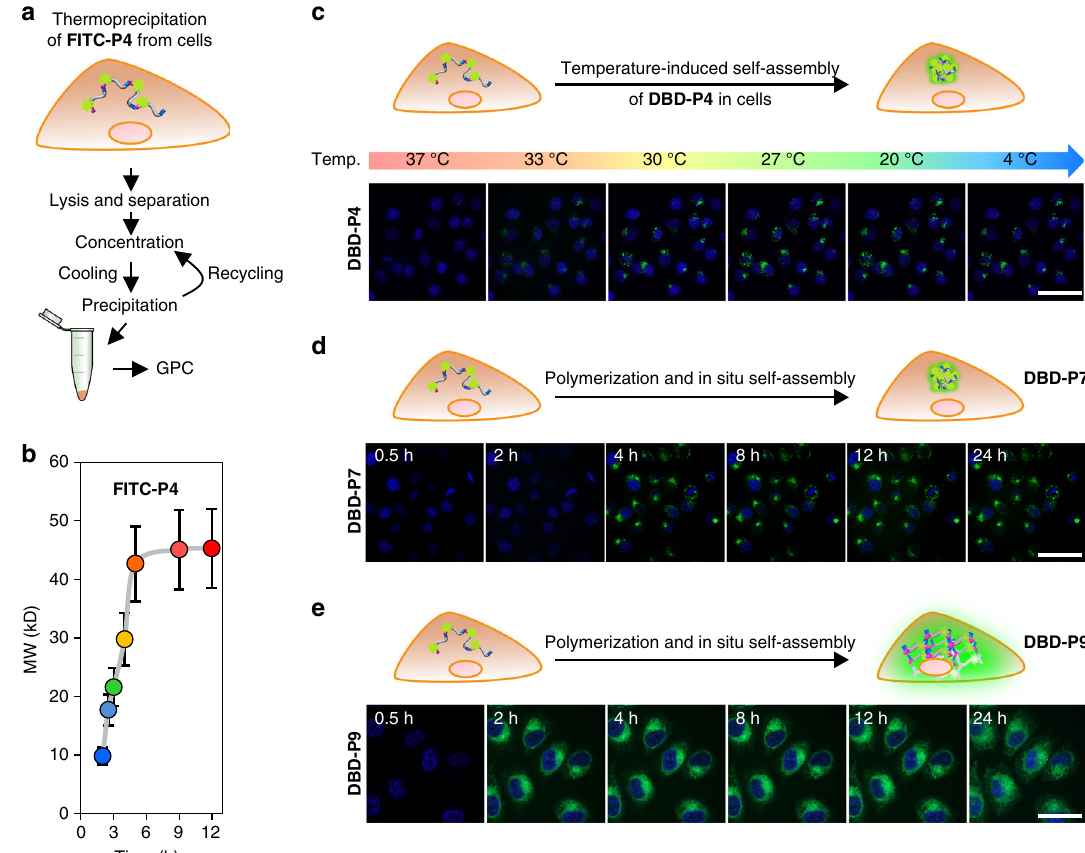
Fig. 4 Intracellular polymerization dynamics of peptide monomers and aggregation process of ELPs. a Schematic illustration of thermoprecipitation of FITC-P4 from cells. b Time-dependent intracellular growth of P4 . The FITC-labeled P4 was obtained at different time point by thermoprecipitation method. The molecular weights (MWs) of these FITC-P4 were measured by GPC. Data were presented as mean ± s.d. ( n = 5). c The thermodynamic self-assembly process of DBD-P4 in HeLa cells during the cooling procedure. The cells were incubated with DBD-peptide 4 (600 μ M) at 37 °C for 12 h before cooling down to 4 °C. DBD-P4 , green; nucleus, blue. Scale bar, 55 μ m. Real-time observation of d , linear growth and e , gel-like ELP formation and in situ aggregation. DBD-P7 and DBD-P9 , green; nucleus, blue. Scale bar, 50 μ